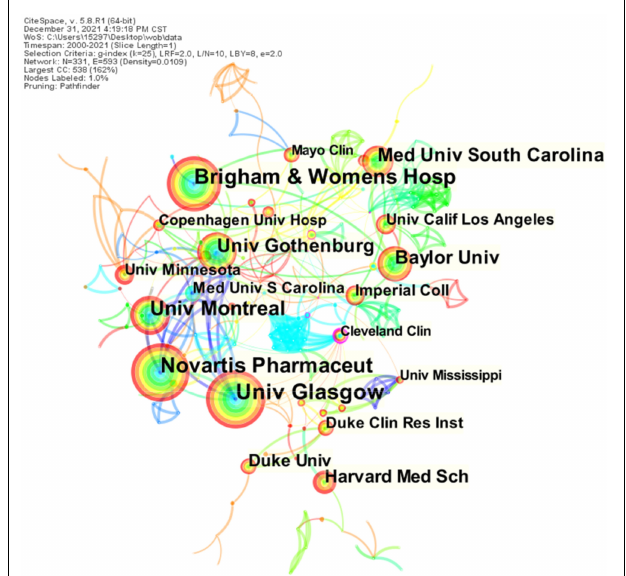
FIGURE 3 | CiteSpace visualization of institutions participating in ARNI’s research in the cardiovascular system. The circular nodes represent institutions; the links between nodes represent interactions between institutions.